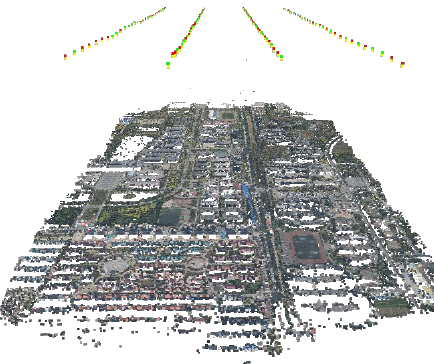
Figure 8. 120 UAV images and the reconstructed strips Figure 8 shows the sparse reconstruction of 120 UAV images using bundler. There are 30 images along each strip. The first image is the upper right one. The initial image matching result of the first image is as follows